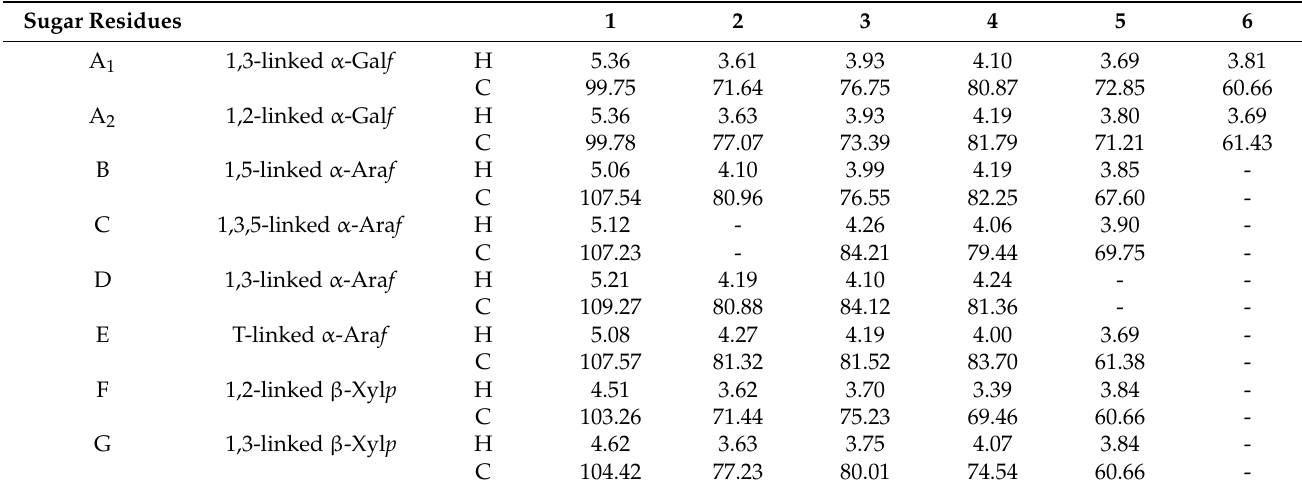
Table 2. 1 H and 13 C NMR chemical shifts (ppm) of JSP-1 recorded in D 2